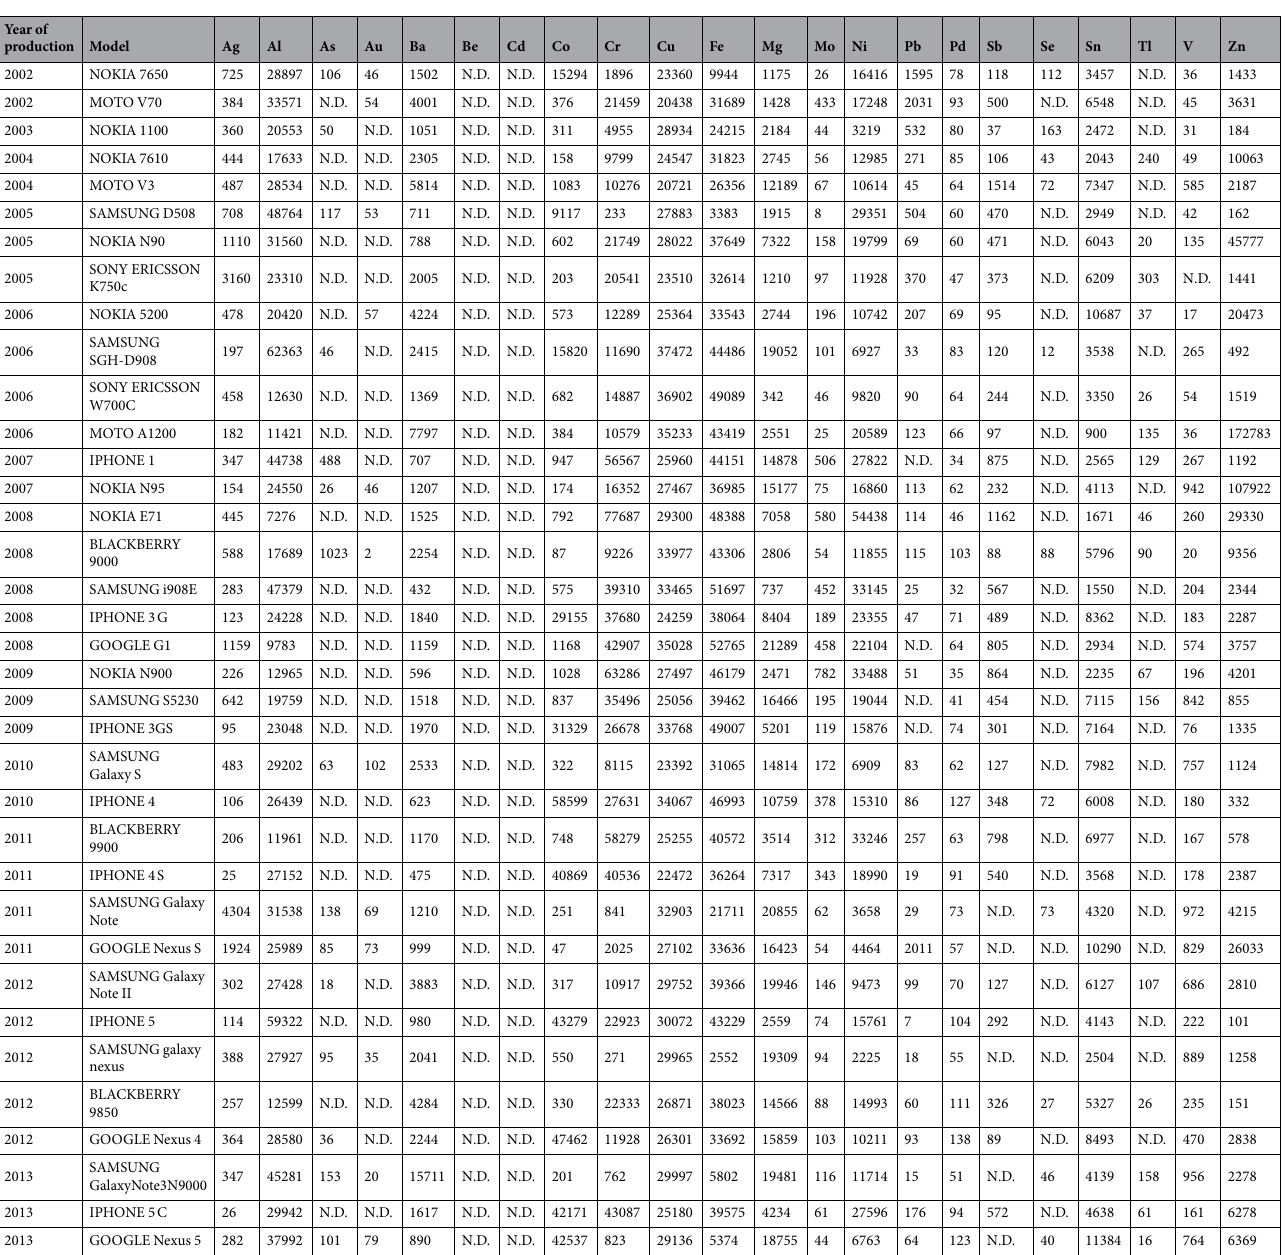
Table 1. Metal content in waste mobile phones. N.D.: not detected; unit of measurement is